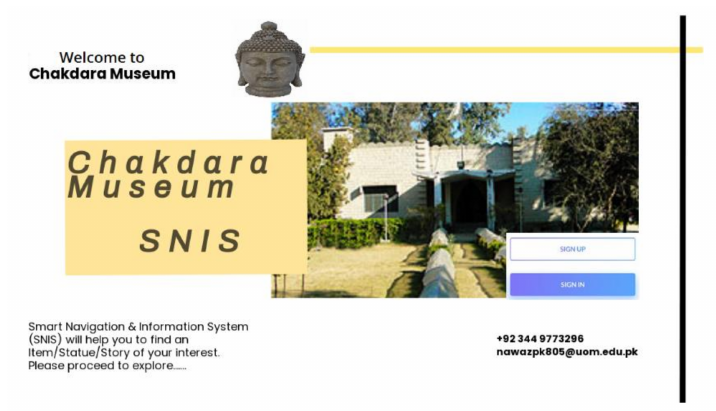
Figure 8. Visitor